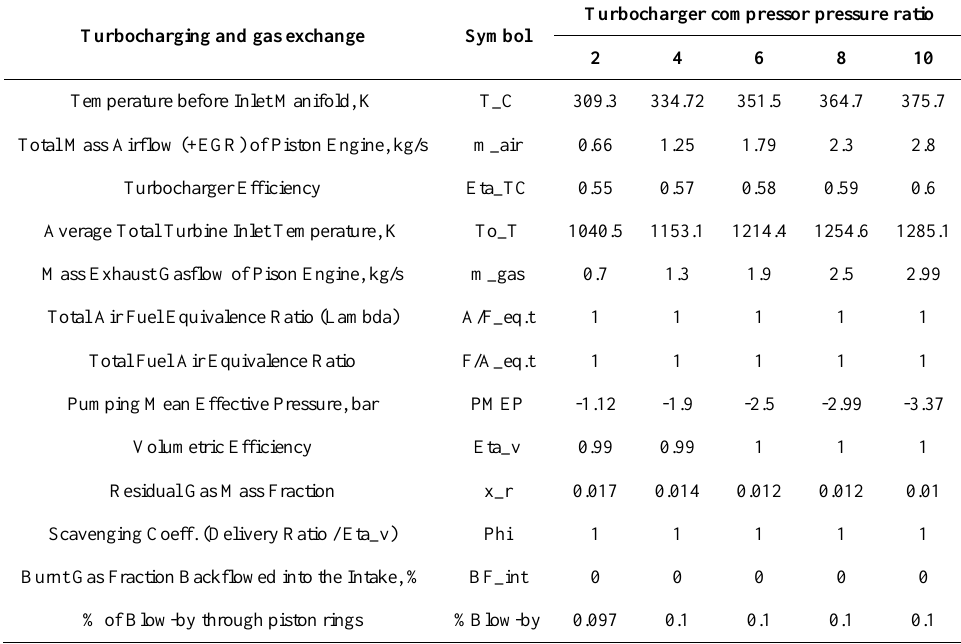
Table 2. Turbocharger and exchange